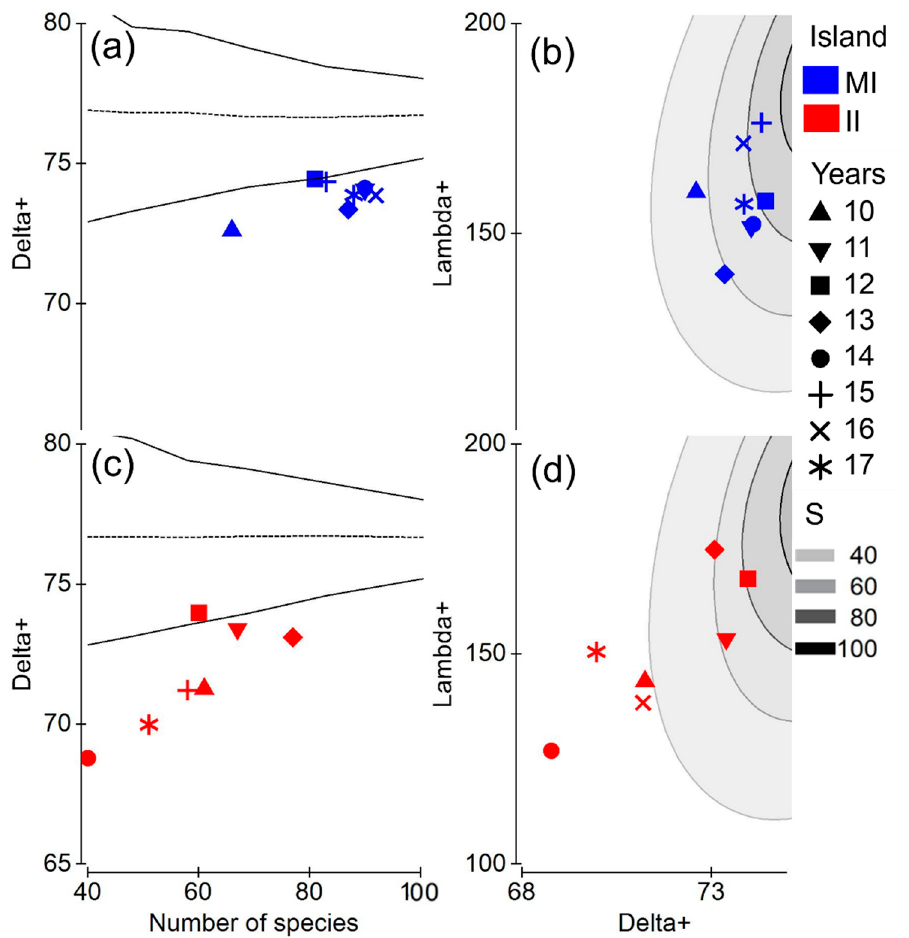
Figure 2. Evaluation of taxonomic distinctness, funnel plot ( a , c ) of the average taxonomic distinc- tiveness ( Δ + ) and the number of species, the dotted line represents the Δ + , and solid lines the degrees of freedom at 95% of the global model. The ellipsoid plot of variation ( b , d ) in taxonomic distinctness ( Λ + ), and the Λ + for the fish assemblages on each of the years of MI and II.